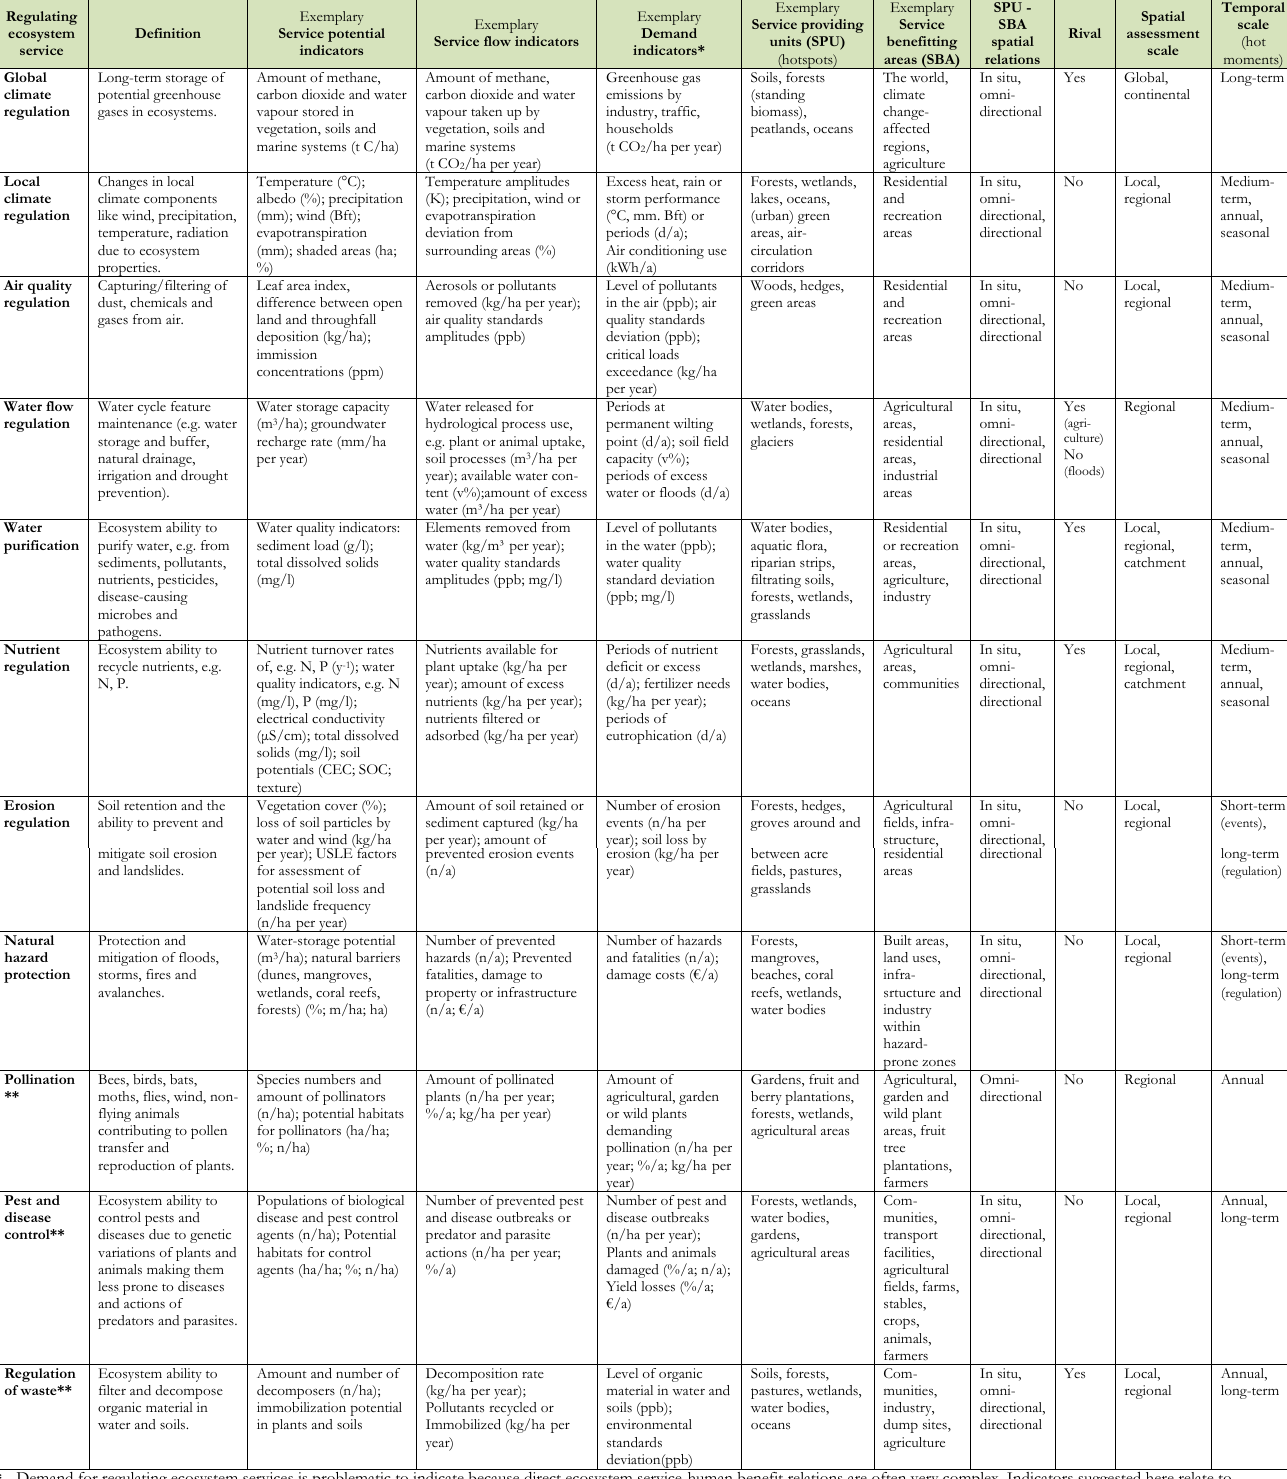
Table 1: Regulating ecosystem services: definitions, service potential (stock) indicators, service flow indicators, demand indicators, exemplary service providing units (hotspots) and service benefitting areas, suggested spatial and temporal assessment scales (based on Kandziora et al. 2013a; Burkhard et al. 2009 and 2012; Schröter et al. 2014; Syrbe and Walz 2012; de Groot et al.